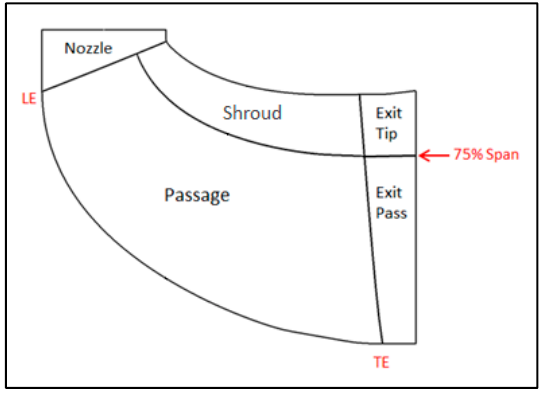
Figure 14. Breakdown of passage into sections for loss analysis.